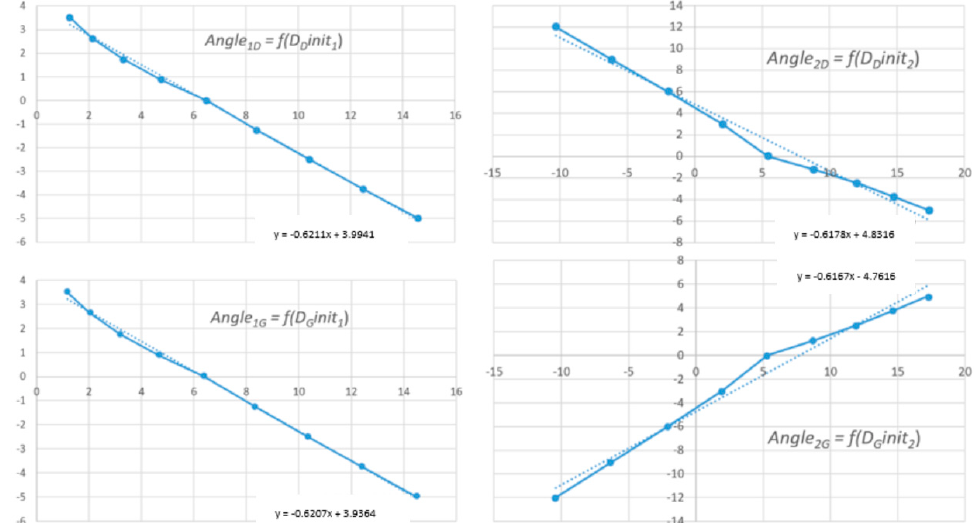
Figure 18. Evolution curves of Angle 1D , Angle 2D , Angle 1G and Angle 2G in function of D D init 1 , D D init 2 , D G init 1 and D G init 2.